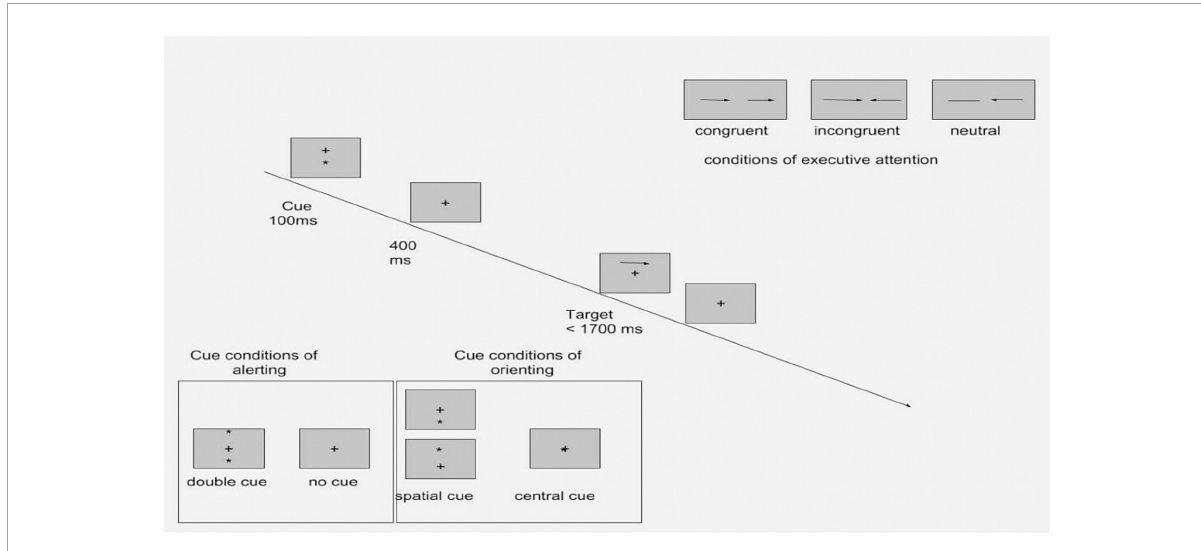
FIGURE1 Experimental procedure of the ANT with four cue conditions and three flanker conditions (Adapted from Fan et al. (46).